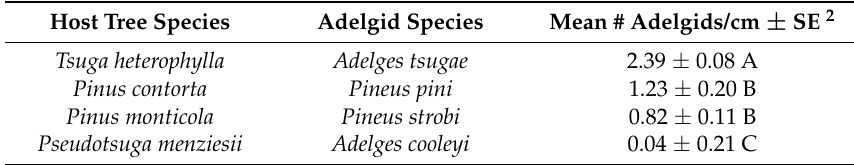
Table 1. Mean number of adelgids ( ± SE) per host tree species, sampled biweekly in Tacoma, WA, USA from October 2015 to November 2016 1 .